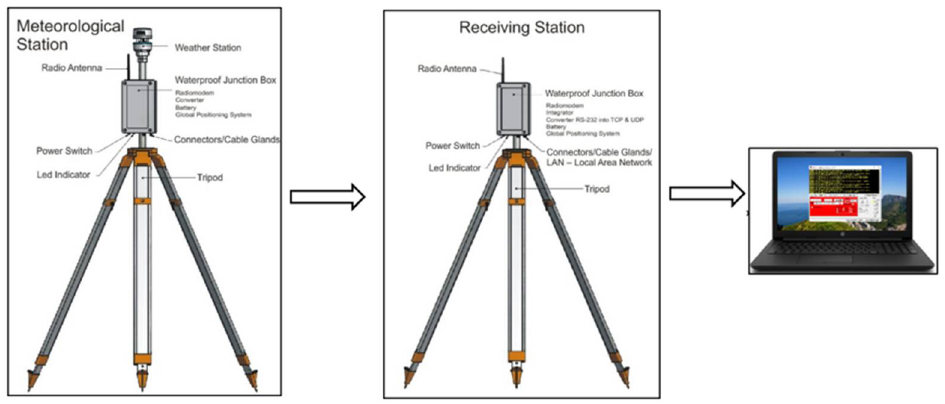
Figure 4. Method of data